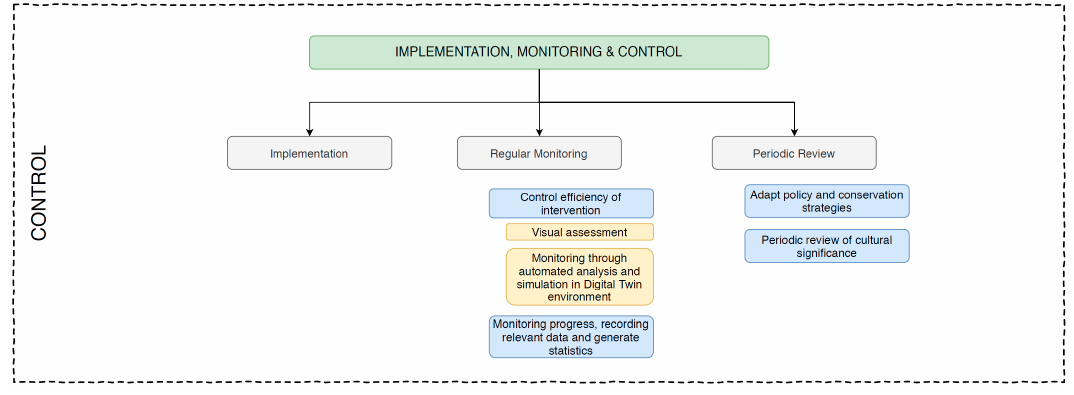
Figure 4. Control: the fourth phase of the management plan process.